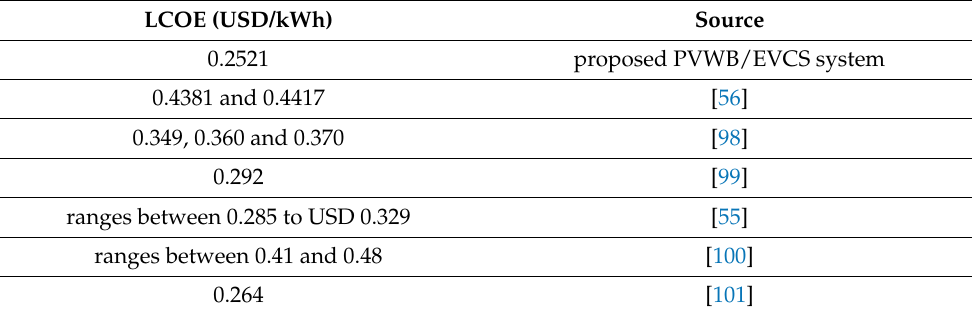
ranges between 0.285 to USD 0.329 ranges between 0.41 and 0.48